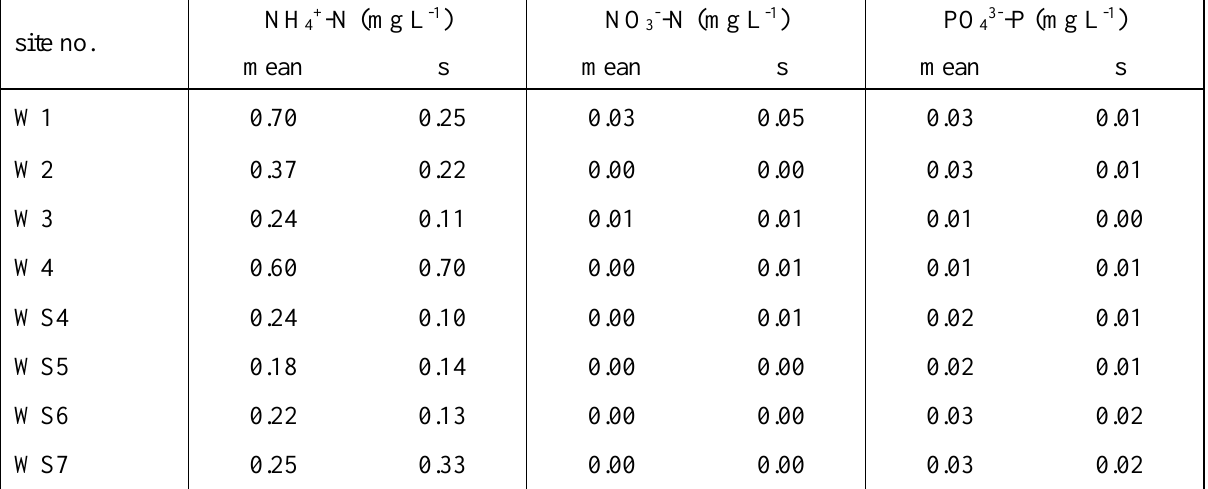
Table A6. Surface water nutrient concentrations at the individual sampling sites from the follow-up examination in